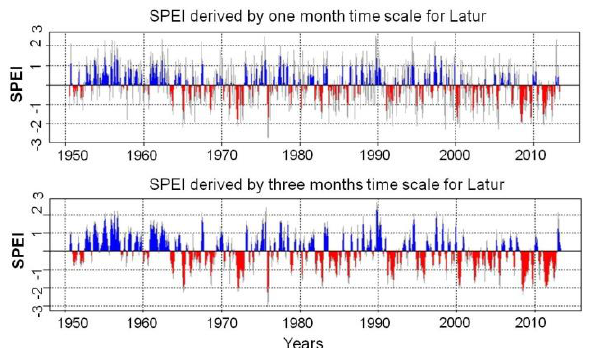
Figure 6. SPEI calculated for one and three month time scales for Latur district.